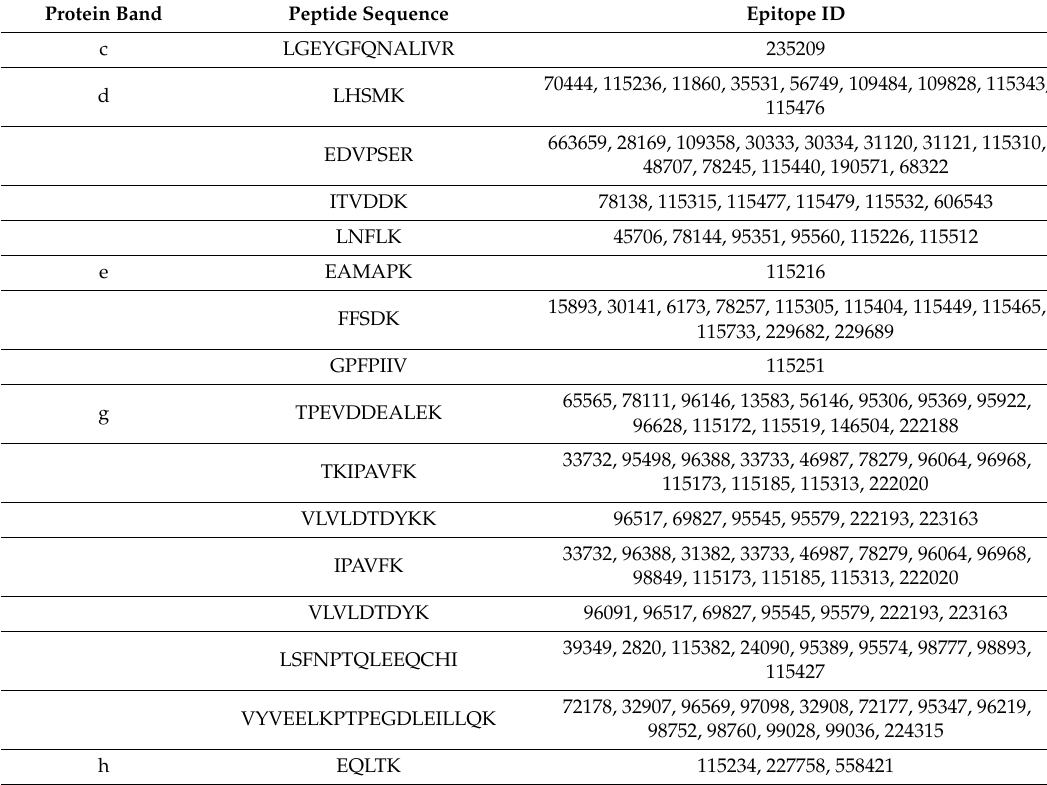
Table 3. List of potential immunogenic sequences recognized in the peptides identified in specific electrophoretic bands of the milk extracts along with the relevant cow’s milk epitope ID reported in Immune Epitope Database